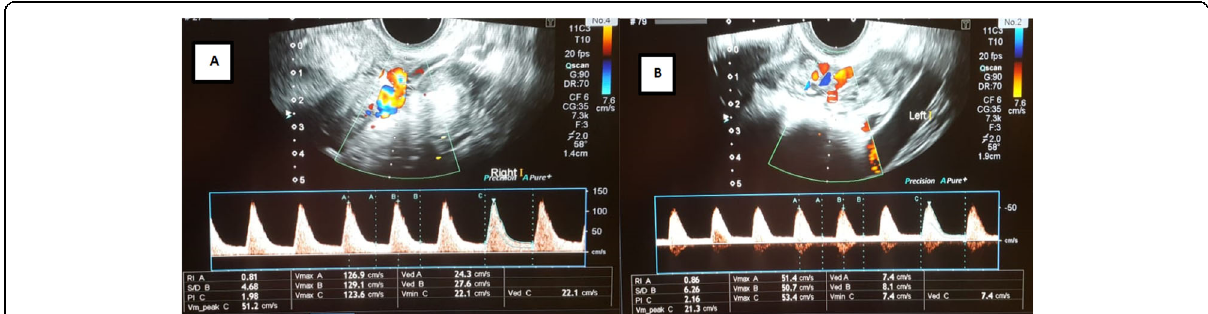
Fig. 6 a , b Transvaginal Doppler ultrasound of both uterine arteries ( a right, b left) of female patient aged 29 years old diagnosed with unexplained infertility shows RI of right and left uterine arteries were 0.8 and 0.86 respectively with mean RI 0.83, S/D ratios of right and left uterine arteries were 4.68 and 6.26 respectively with mean S/D ratio 5.47, and PI of right and left uterine arteries were 1.98 and 2.16 respectively with mean PI 2.07